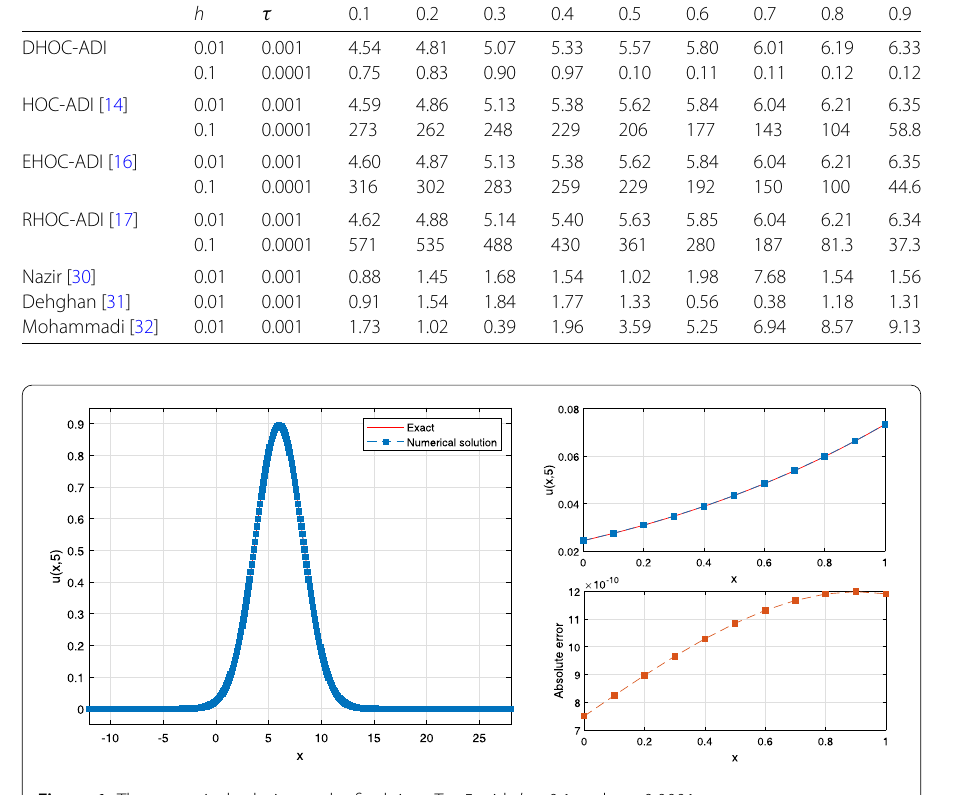
Figure 1 The numerical solution at the final time T = 5 with h = 0.1 and τ =